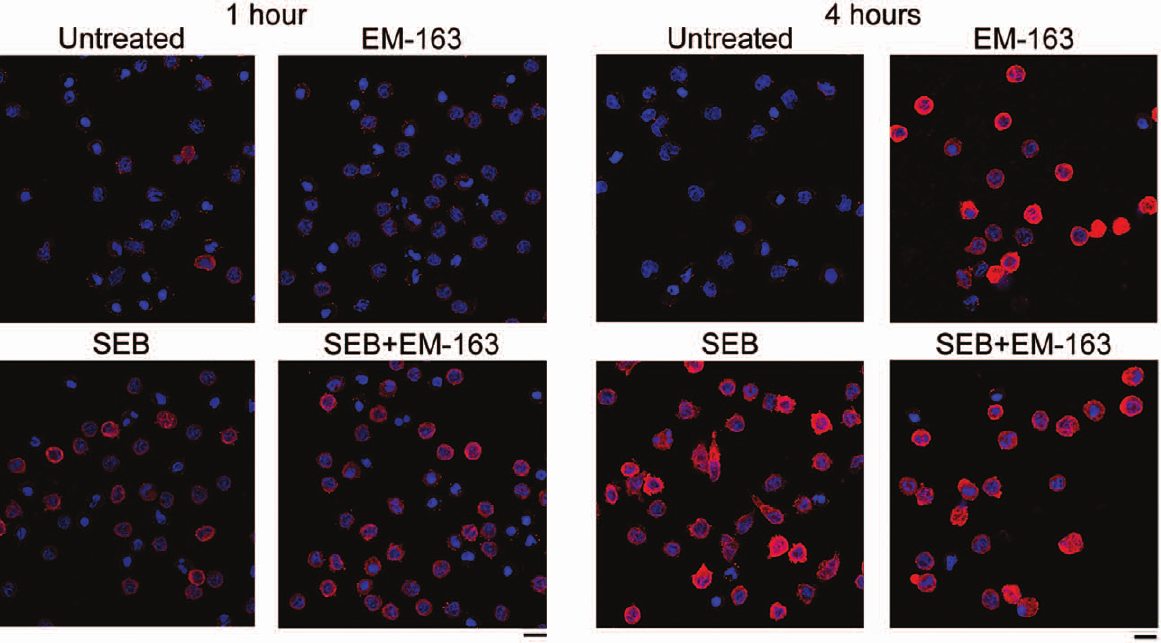
Figure 4. SEB stimulation of human monocytes in the presence of EM-163 leads to intracellular accumulation of MyD88. Increased accumulation of MyD88 in CD14 + monocytes treated with SEB in the presence of EM-163 at 1 h and 4 h. Confocal images show expression of nuclei (blue) and intracellular MyD88 (red) proteins in CD14 + monocytes. Monocytes were untreated or treated with SEB, EM-163 or SEB plus EM-163 (250 m M). Cell nuclei were labeled with DAPI (blue). Scale bar =10 m m. Data reperesent three similar experiments with different donors.